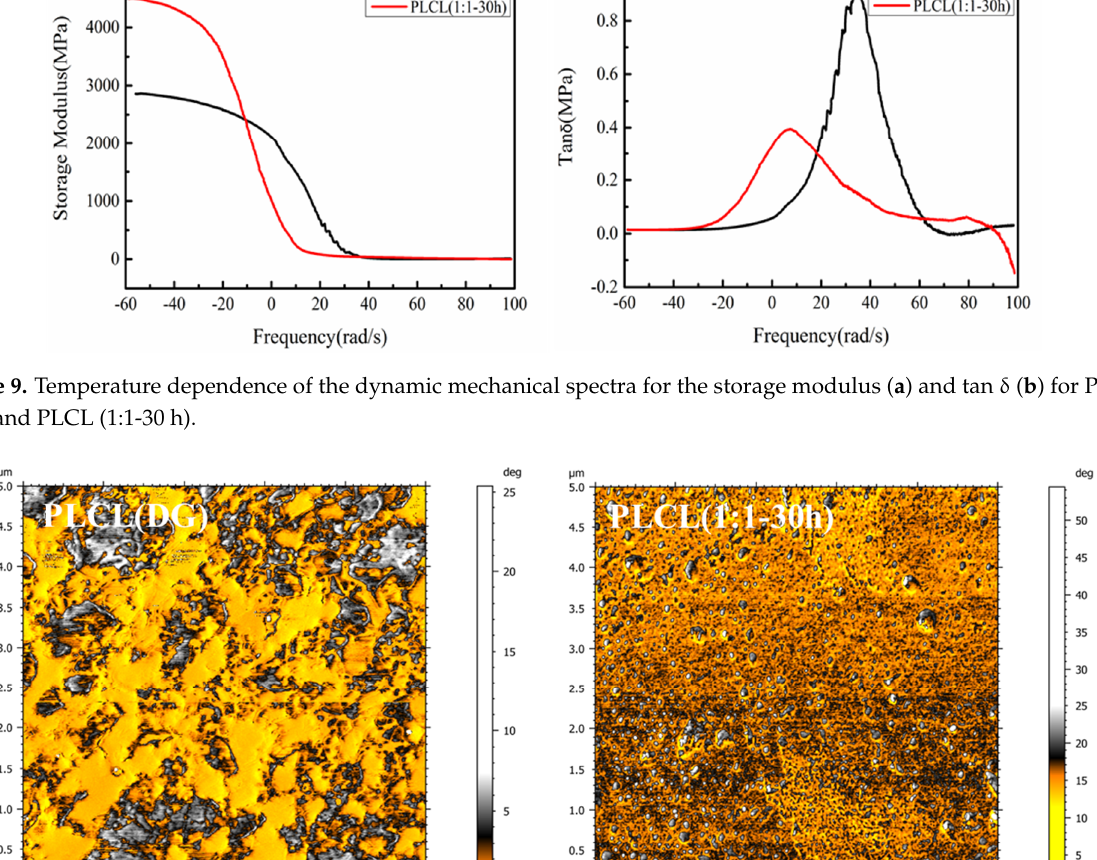
Figure 9. Temperature dependence of the dynamic mechanical spectra for the storage modulus ( a ) and tan δ ( b ) for PLCL (DG) and PLCL (1:1 - 30 h).